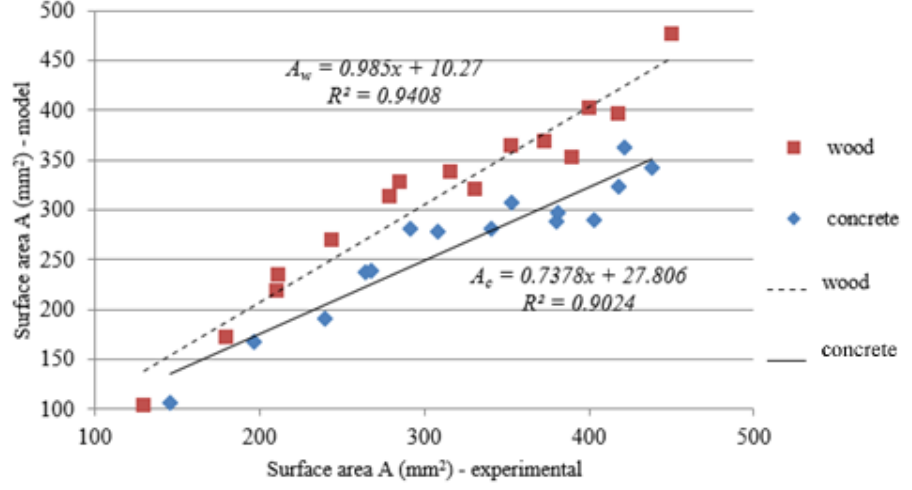
Figure 4. Comparison of contact surfaces obtained from experimental studies and based on a numerical model, for both substrates. Aw — means contact surface for wood surface, Ac — means contact surface for concrete surface.